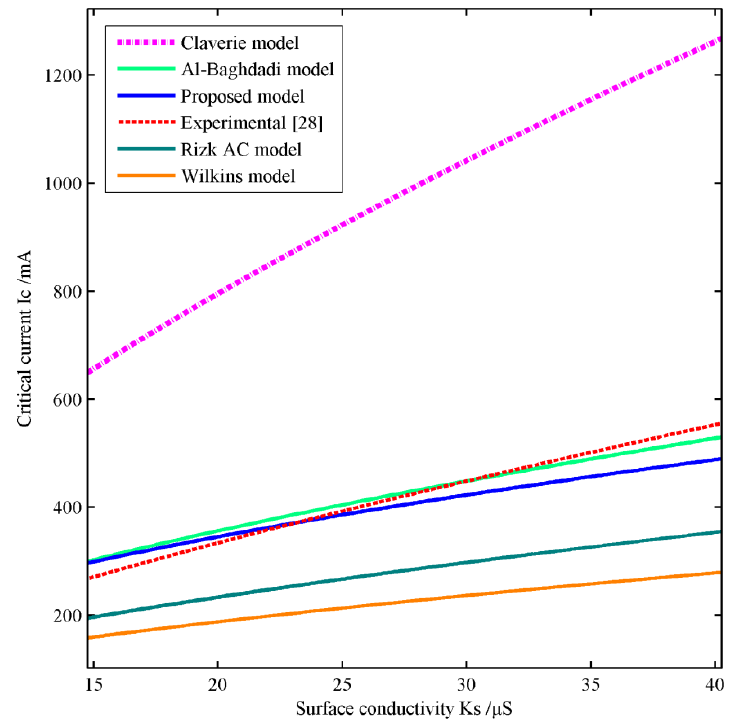
Figure 7. The relationship between surface conductivity and critical flashover current for various